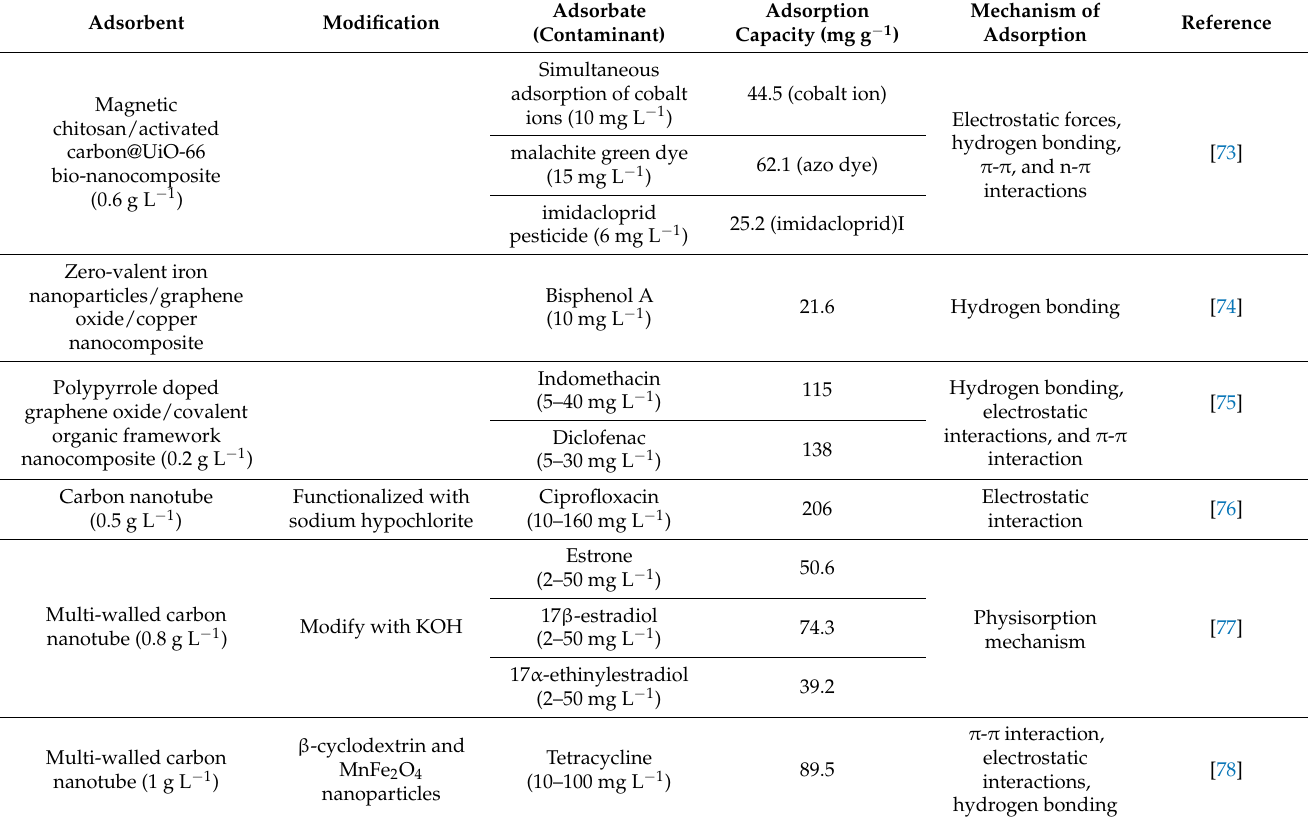
Table 2. Application of different nanomaterials in the adsorption of several emerging